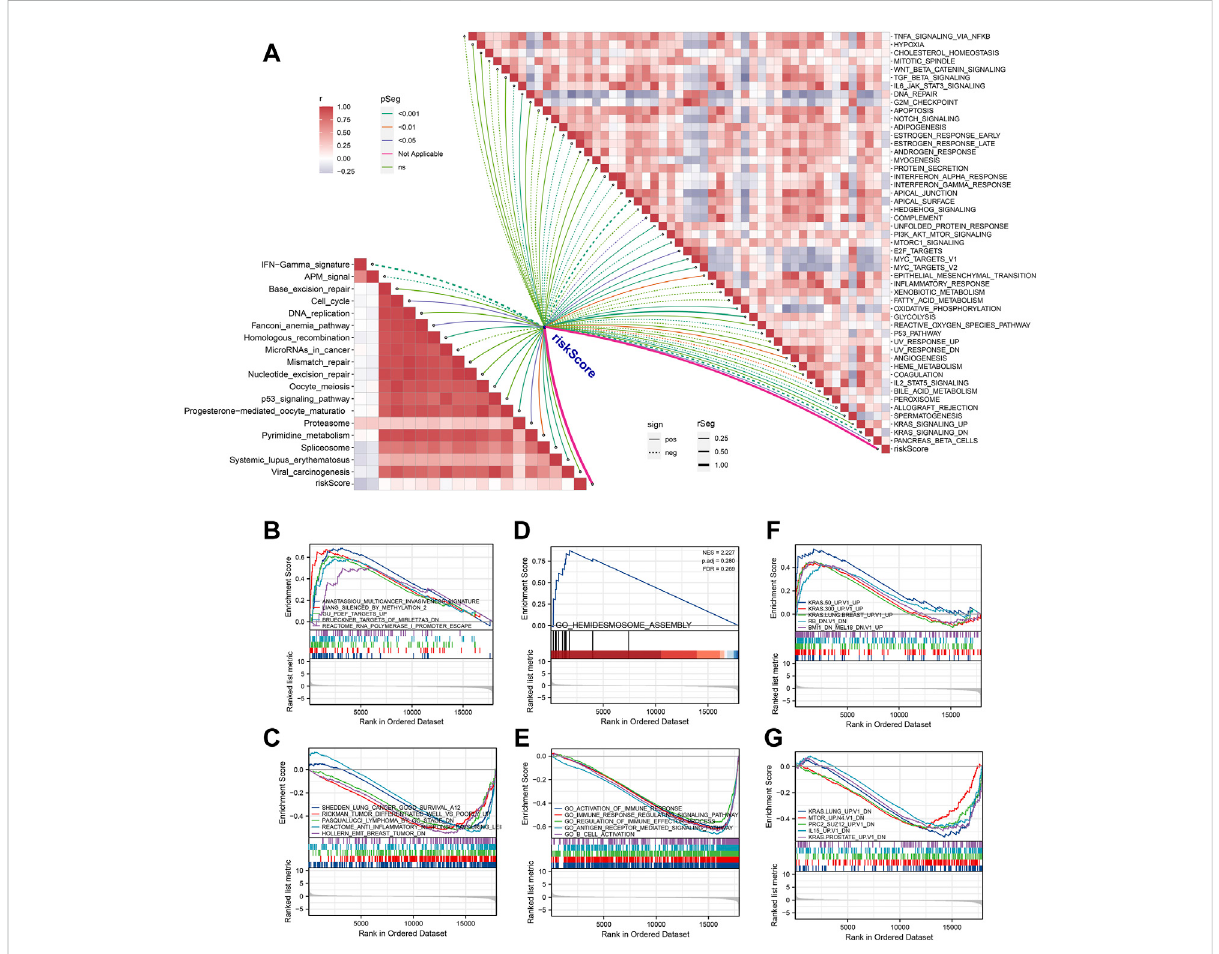
FIGURE 5 Pathway enrichment analysis of the signature. (A) Correlation analysis between riskscore and the enrichment scores of immunotherapy- predicted pathways as well as hallmark gene signatures. (B , C) Using curated gene sets, GSEA analysis was performed between two risk groups. (D , E) Using ontology gene sets, GSEA analysis was performed between two risk groups. (F , G) Using oncogenic signature gene sets, GSEA analysis was performed between two risk